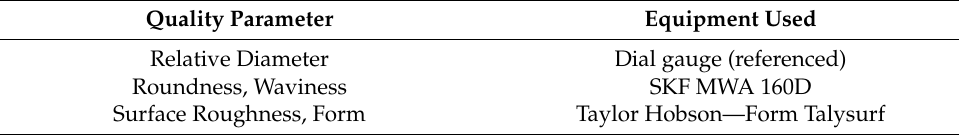
Table 2. Measured Quality